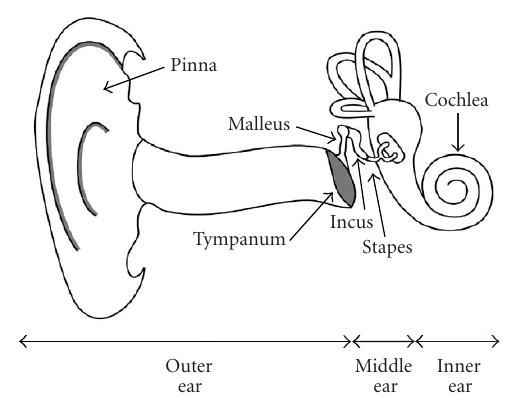
Figure 1: A cut-away view of the human ear. This shows the three stages of the ear. The outer ear includes the pinna, the ear canal, and the tympanum (ear drum). The middle ear is composed of three small bones, or ossicles. Simply put, these three bones work together for gain control and for impedance matching between the outer and the inner ear. The inner ear is the snail-shaped bone called the cochlea. This is where the incoming sounds are decomposed into the respective frequency components.